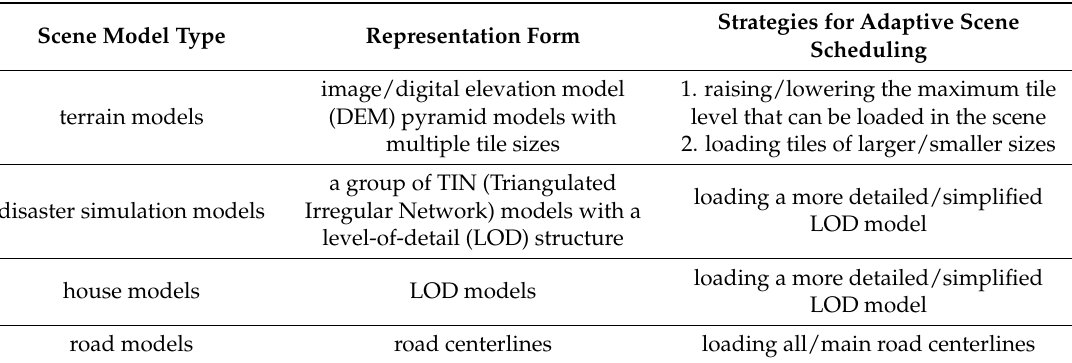
Table 1. Strategies for adaptive scene scheduling.